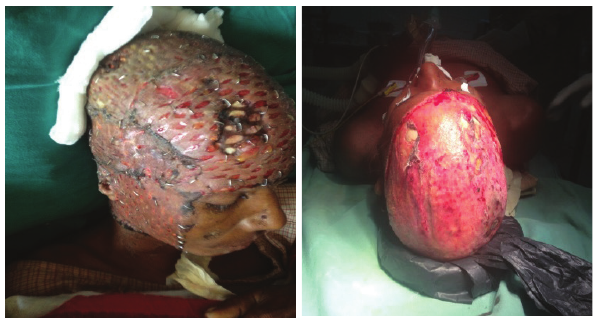
Fig 4 and 5: Avulsion of scalp with intact